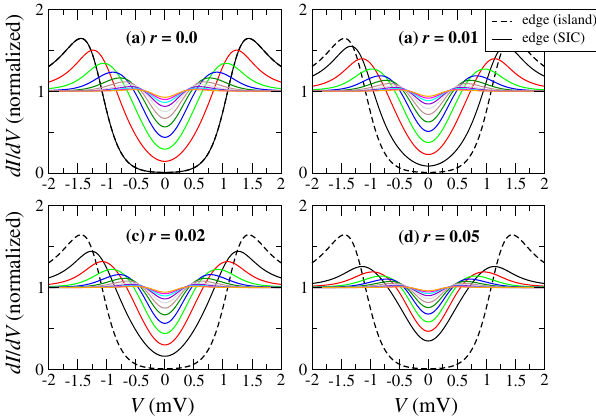
FIG. 9. Normalized tunneling conductance at T ¼ 0 . 55 K as a function of the bias voltage for different values of the interface parameter r , as indicated in the panels. The different curves correspond to different positions along the monolayer, x . The curves were computed in steps of 10 nm ranging from x ¼ 0 (island edge) to x ¼ 100 nm. The black dashed lines in the different panels correspond to the spectra inside the island, while the black solid lines are the results obtained on the monolayer side of the island edge. Notice the discontinuity in the spectra at the island edge when r ≠ 0